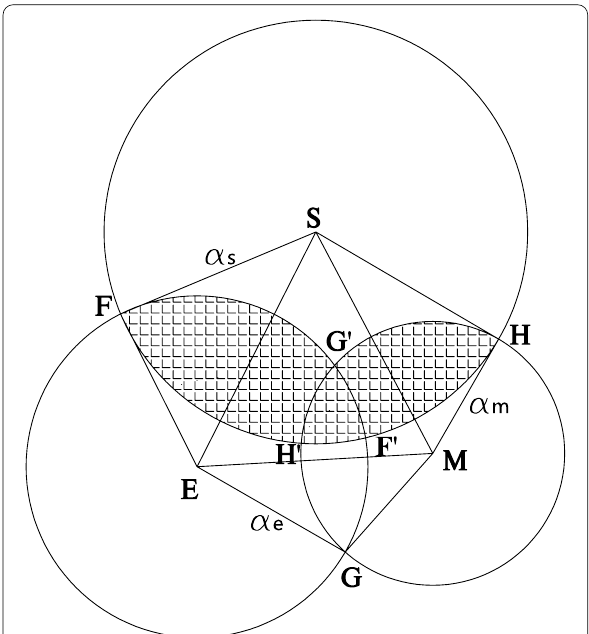
Fig. 1 Occultation of the Sun by the Earth and the Moon (S: the Sun; E: the Earth; M: the Moon). α s , α e and α m stand for the radius of the Sun, the Earth, and the